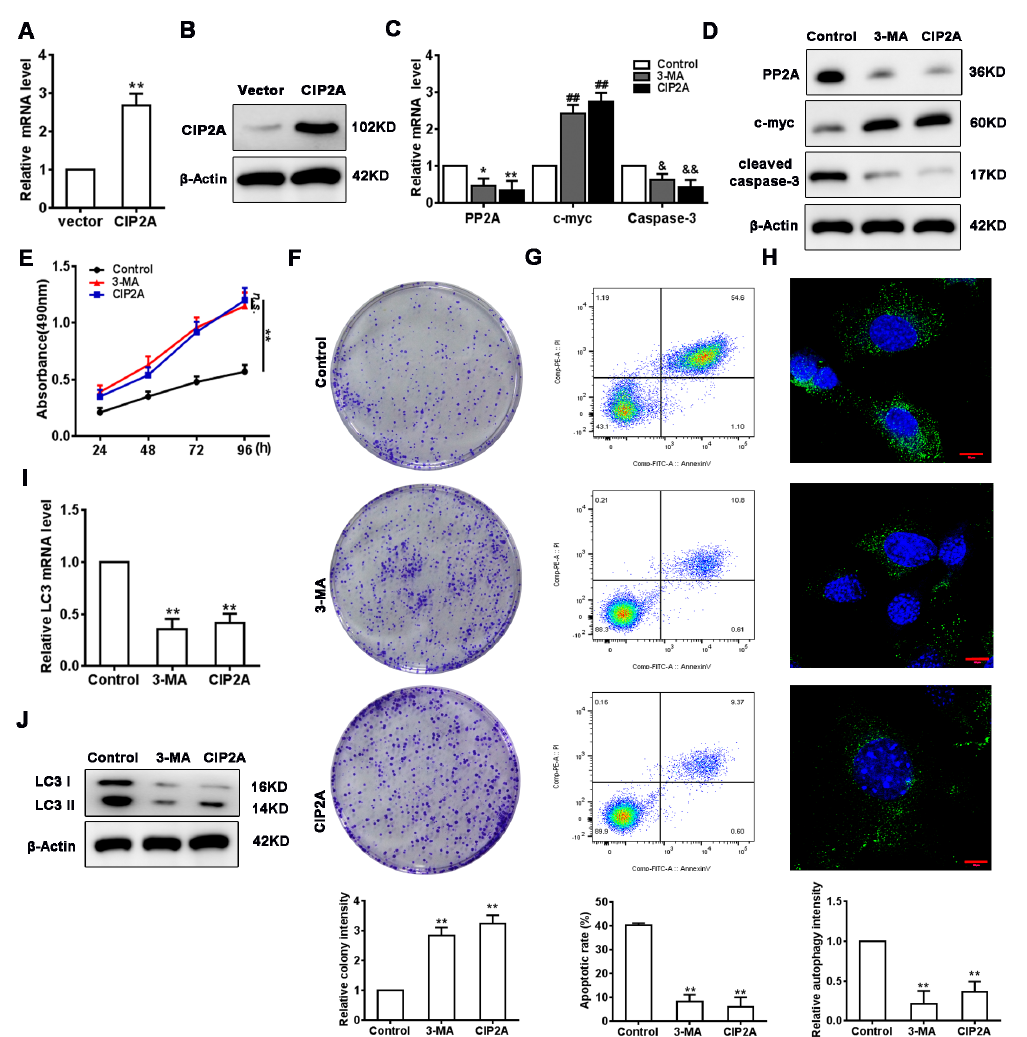
Figure 6. Verification of the PI3K/mTORC1 pathway on Diane-35 and metformin-mediated autophagy. ( A , B ) Transfection efficiency of the CIP2A overexpression system in Ishikawa cells. ( C , D ) mRNA and protein levels of PP2A, c-Myc, and cleaved caspase-3 in cells subjected to different treatments. CCK-8 ( E ), colony formation ( F ), and flow cytometry ( G ) were performed to measure apoptosis in Ishikawa cells after pretreatment with 3-methyladenine (3-MA, 5mM) or transfection with the CIP2A overexpression vector. All the cells were treated with Diane-35 and metformin (10 mM). ( H – J ) Cell autophagy was determined using the LC3 level measured by qRT-PCR, Western blotting, and immunofluorescence. Data are shown as the mean ± S.D. n.s. = no statistically significant differences. * p < 0.05, # p < 0.05, & p < 0.05, and ** p < 0.01, && p < 0.01, ANOVA. Scale bars = 10 μm.